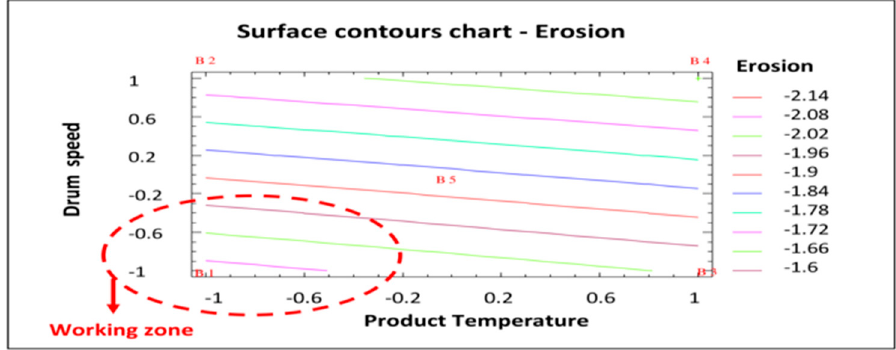
Figure 5. Surface contours chart—Erosion. B1: Show the conditions assayed of Batch 1, etc.